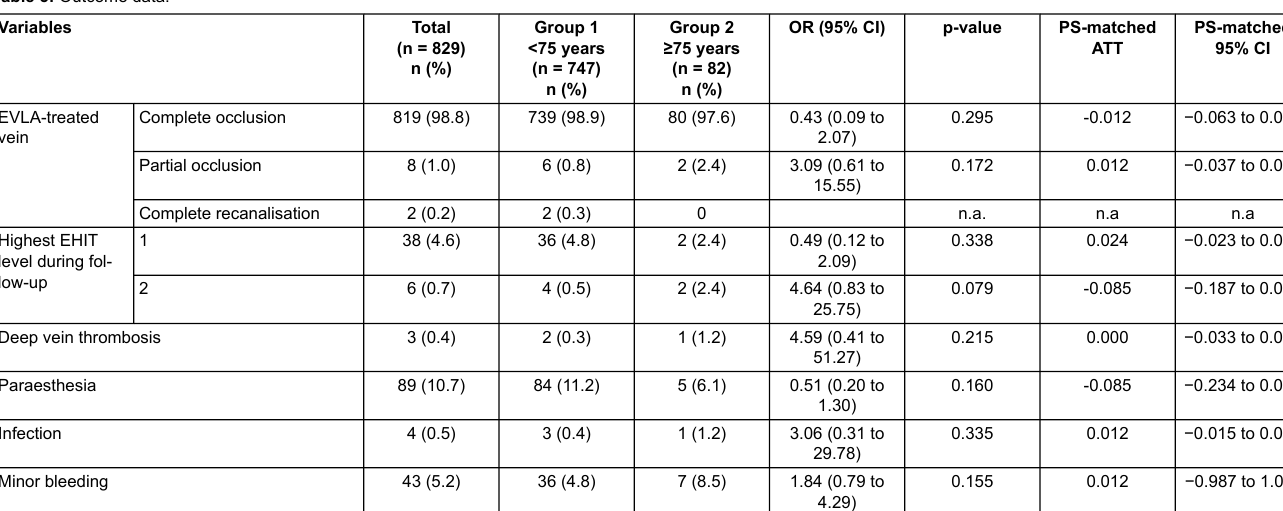
Table 3: Outcome data. Variables